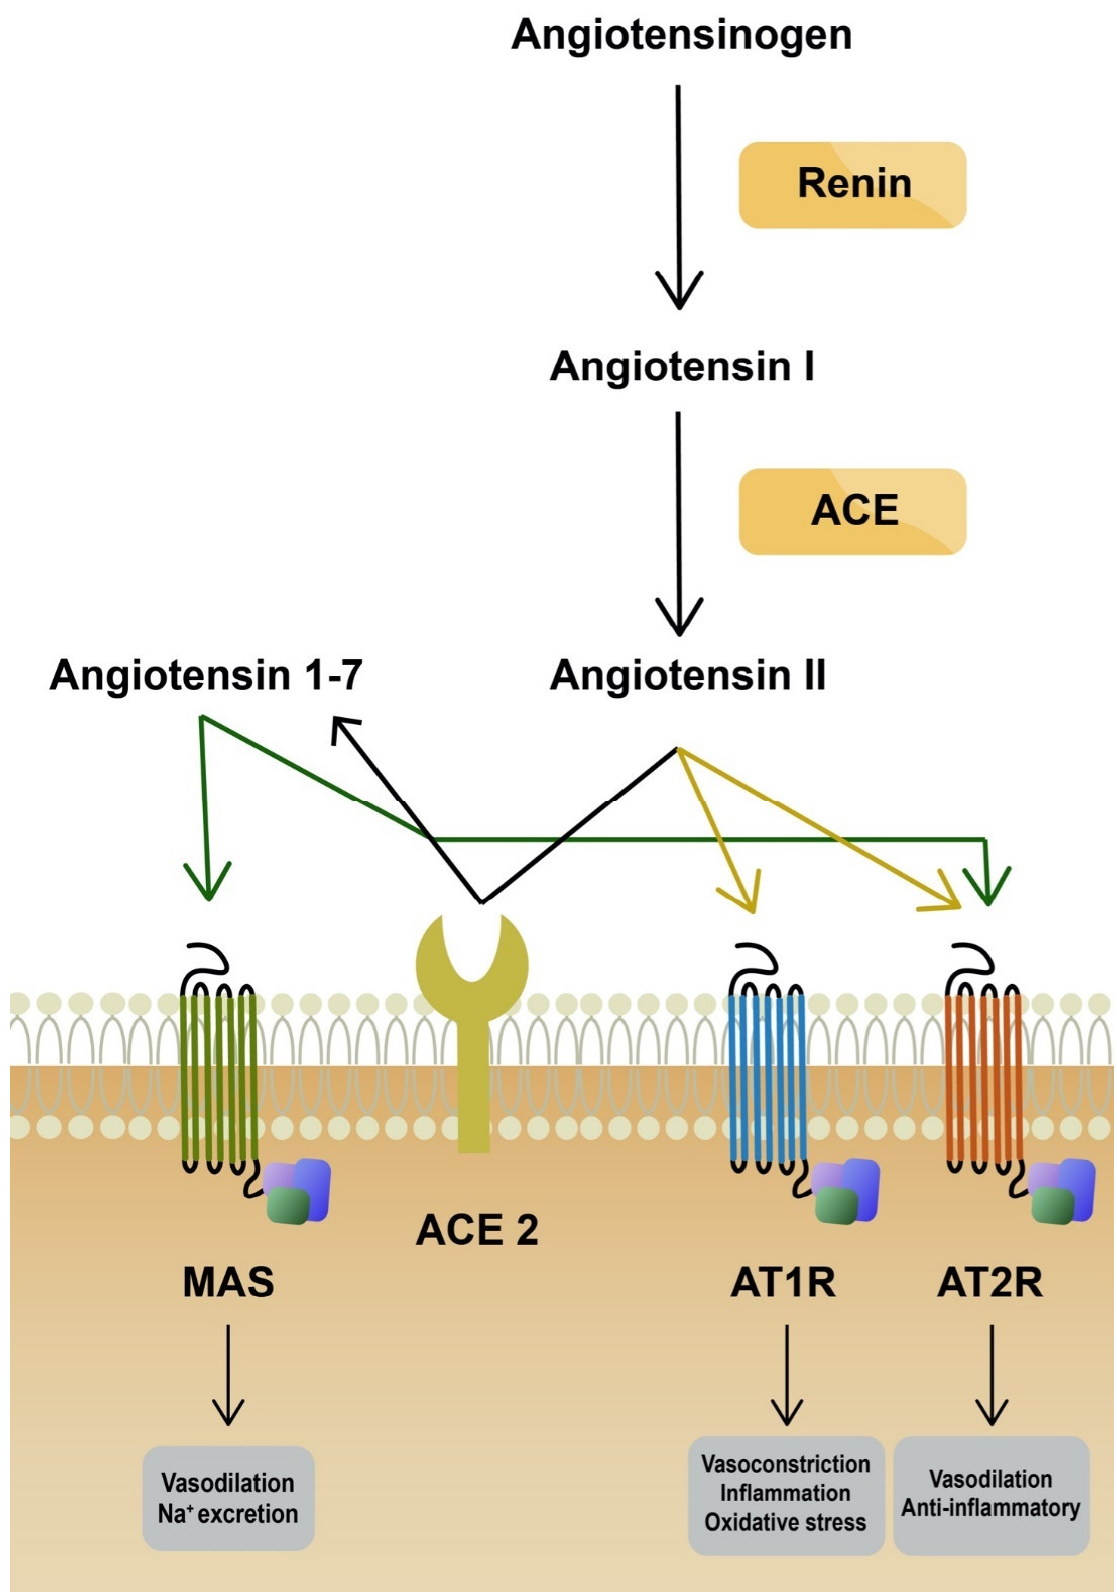
Figure 1. Angiotensin pathways: ACE—angiotensin convertase enzyme; ACE2—angiotensin con- vertase enzyme type 2; AT1R—angiotensin II type 1 receptor; AT2R—angiotensin II type 2 recep- tor.